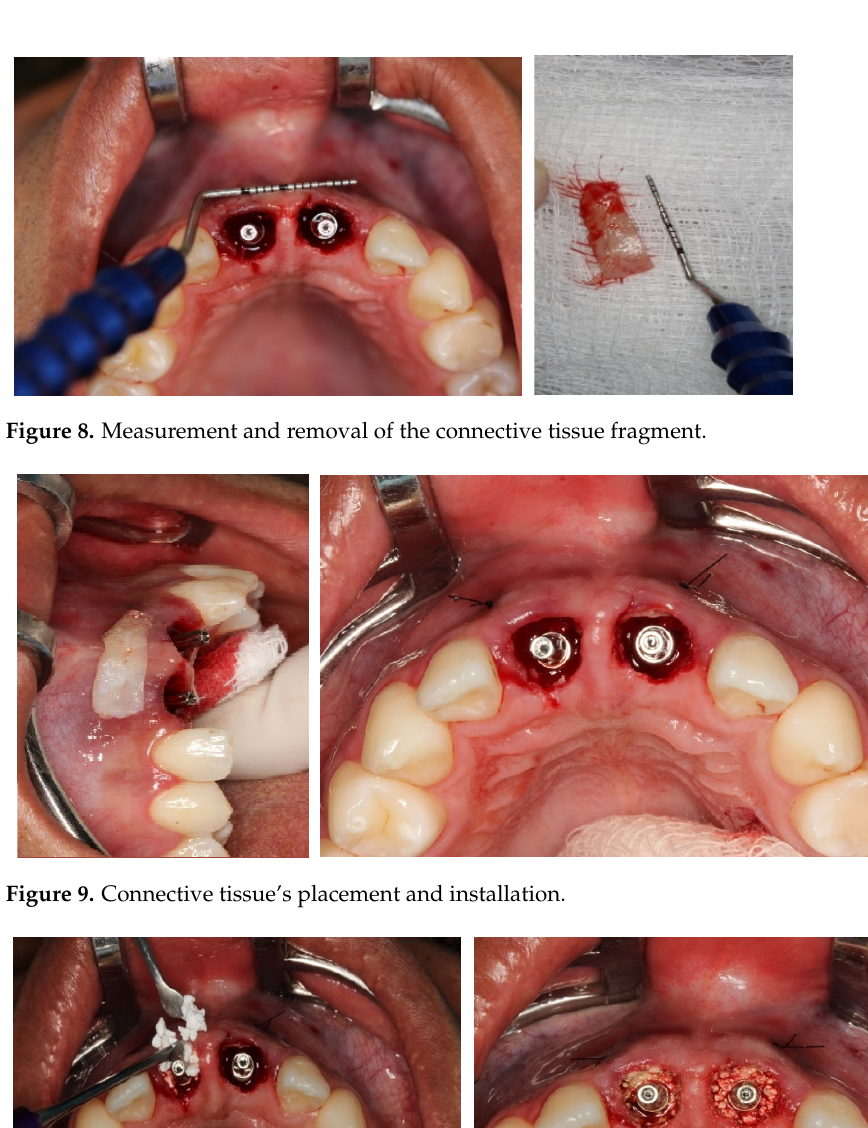
Figure 7. Installation of the surgical guide and Implants installed in the correct positioning and installation of cemented components.